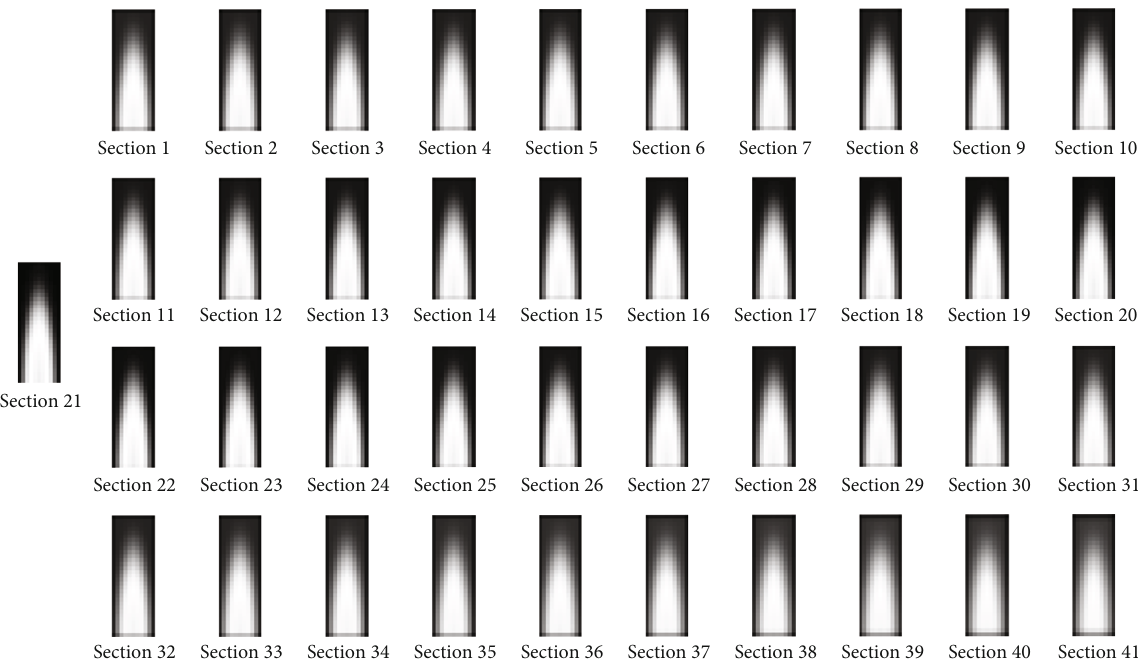
Figure 10: The refocus image sequences of the fl ame.